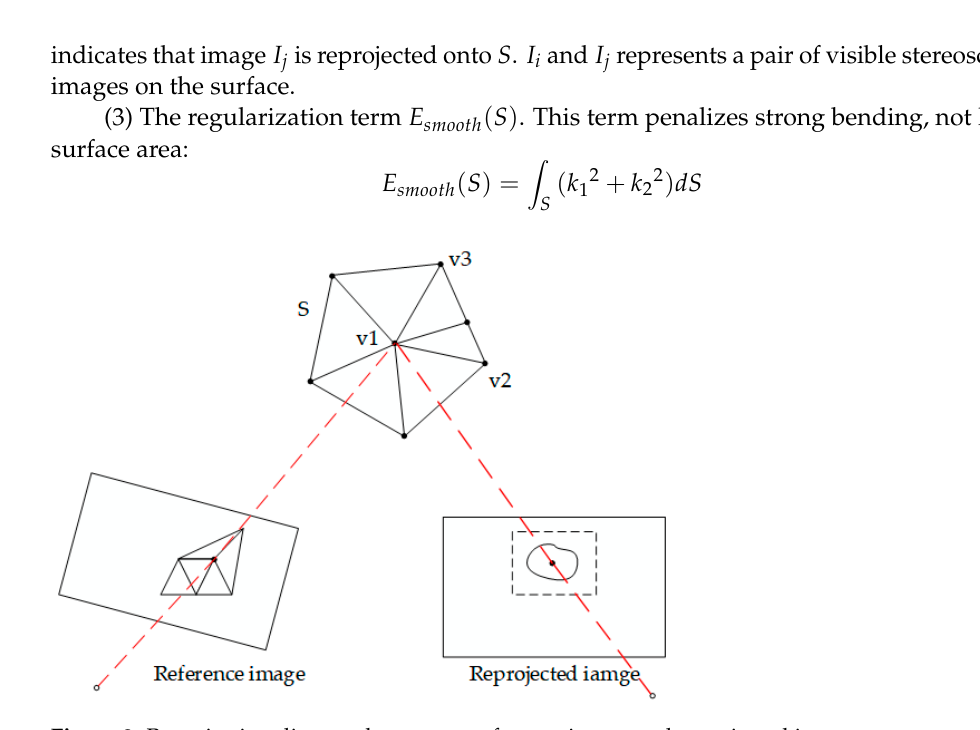
Figure 2. Reprojection diagram between a reference image and reprojected image.